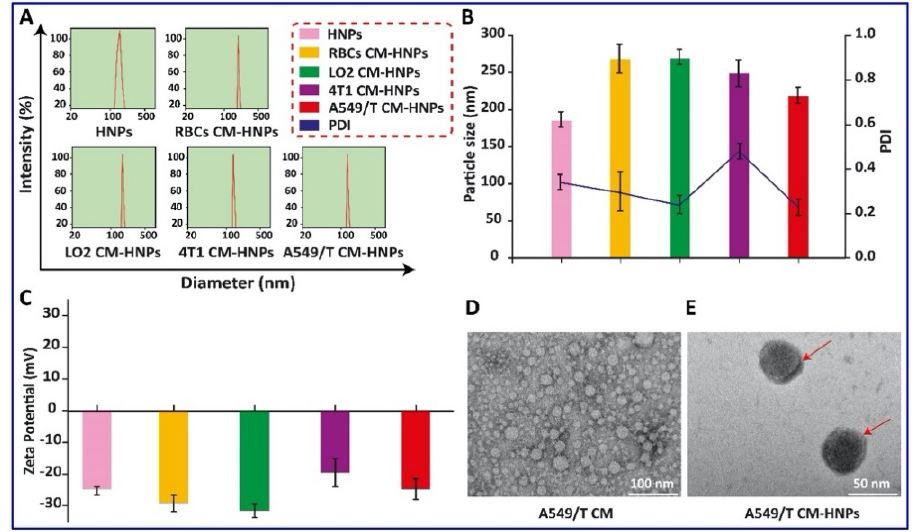
Figure 5. Preparation and characterization of biogenic HNPs. ( A , B ) Particle size and PDI, ( C ) surface charge, ( D , E ) TEM images. Table 1. Drug loading (DL) and encapsulation efficiency (EE) of various formulations.